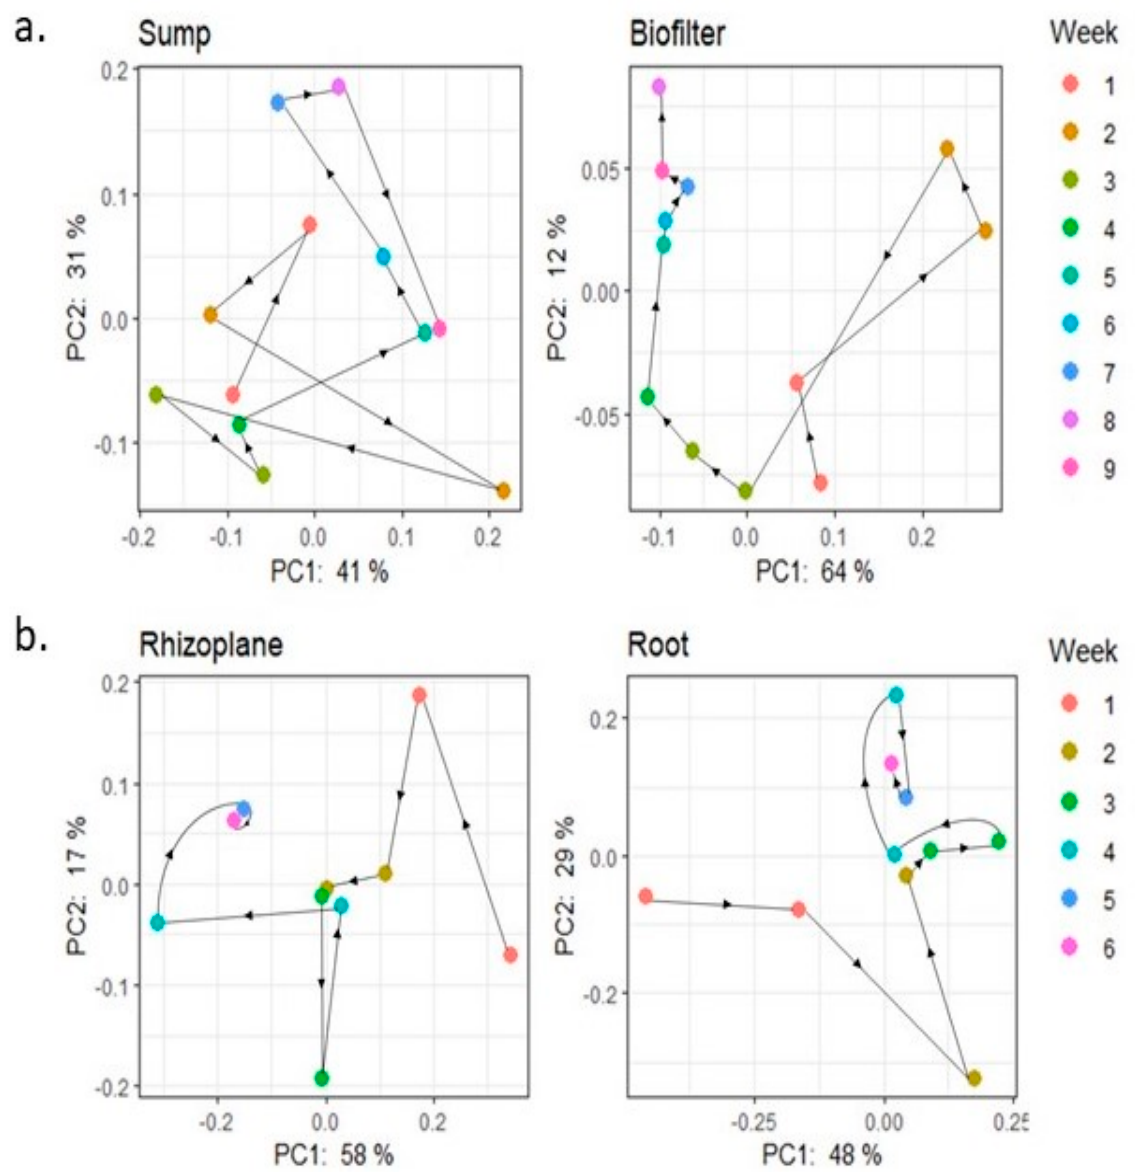
Figure 7. Weighted Unifrac PCoA per compartment showing the repartition of the samples week after week in the sump and biofilter ( a ) and in the rhizoplane and root ( b ) compartments. Arrows link the sampling dates in the chronological order. The biofilter, rhizoplane and root compartments seem to present an evolution throughout time.